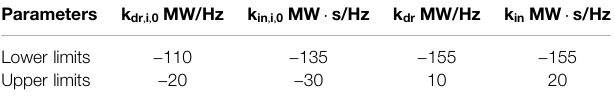
TABLE 1 | The range of optimized